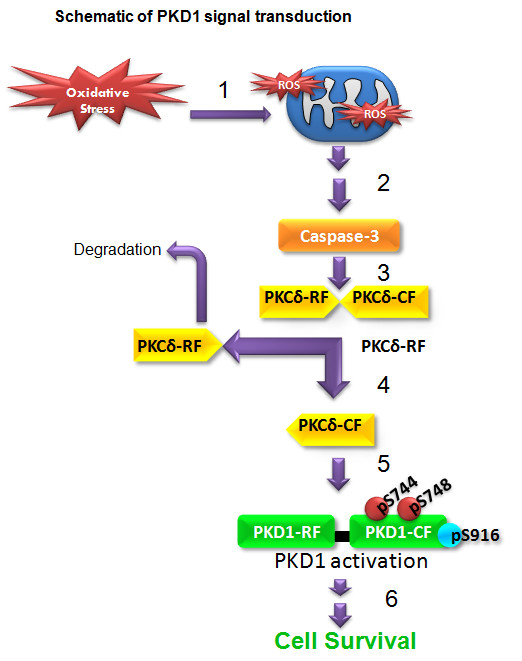
Schematic of PKCδ-PKD1 signal transduction mechanism during oxidative stress in dopaminergic neuronal cells. 1) Oxidative stress causes mitochondrial impairment; 2) activation of caspase cascade; 3) caspase-3 mediates proteolytic cleavage of PKCδ; 4) proteolytically cleaved PKCδ-catalytic fragment (CF) is active; 5) PKCδ-CF activates PKD1 by activation loop phosphorylation during the early stage of oxidative stress; 6) Fully active PKD1 regulates cell survival function in N27 dopaminergic cells.